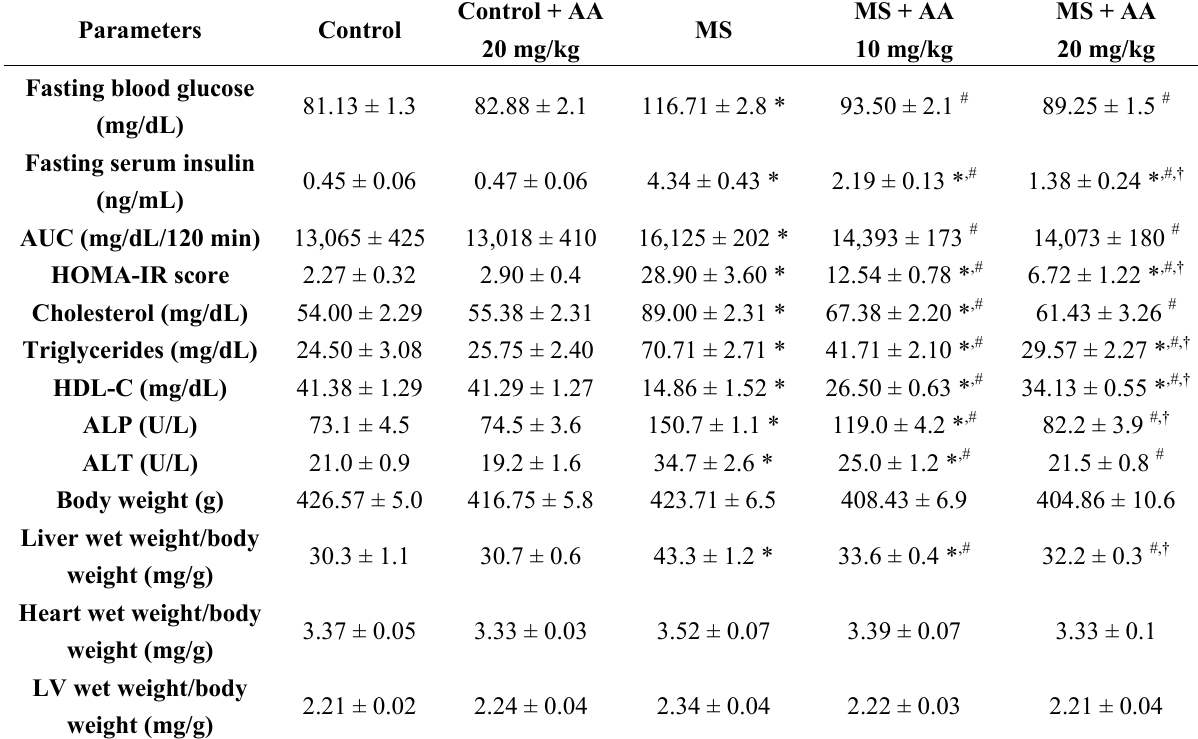
Table 1. Fasting blood glucose, biochemical parameters, body and organ weight in all experimental groups. Results are expressed as mean ± SEM. AA represents asiatic